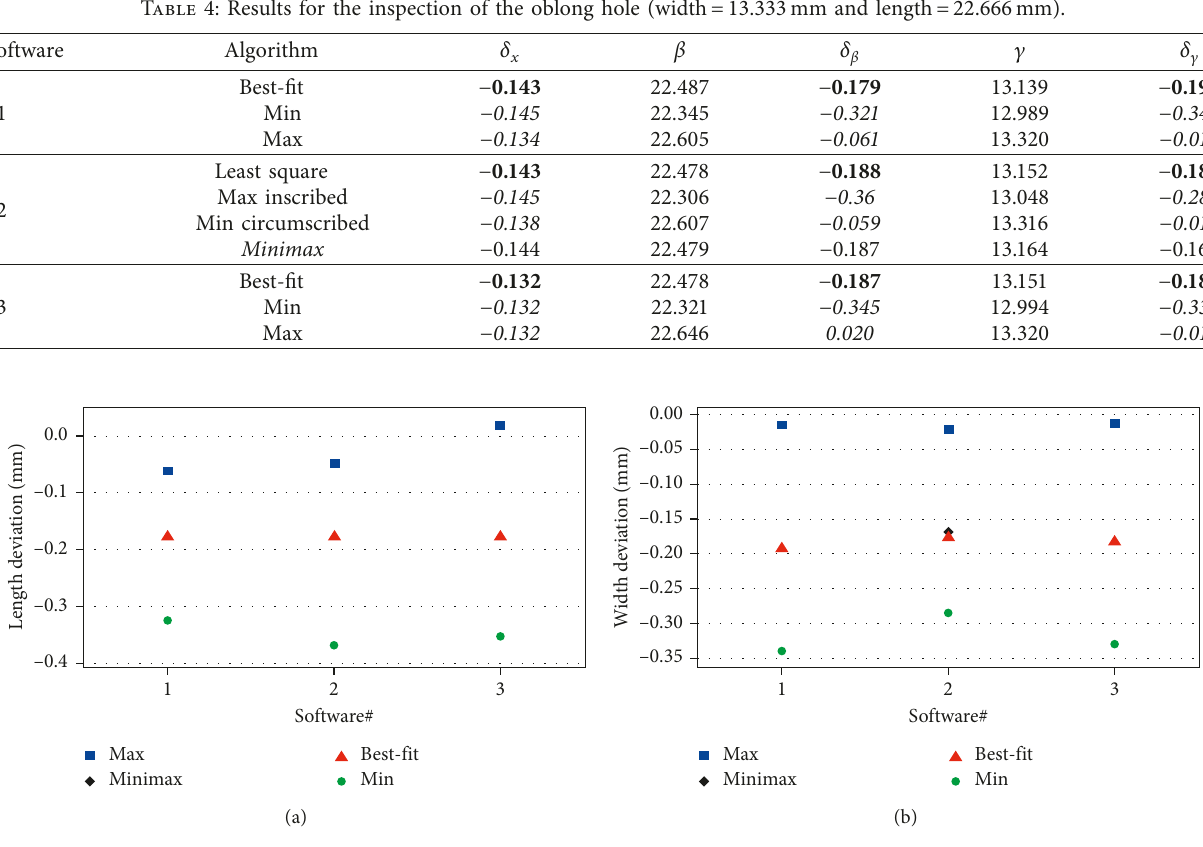
Figure 6: Results for the oblong hole. (a) Length deviation. (b) Width deviation. Table 5: Results for the inspection of Plane